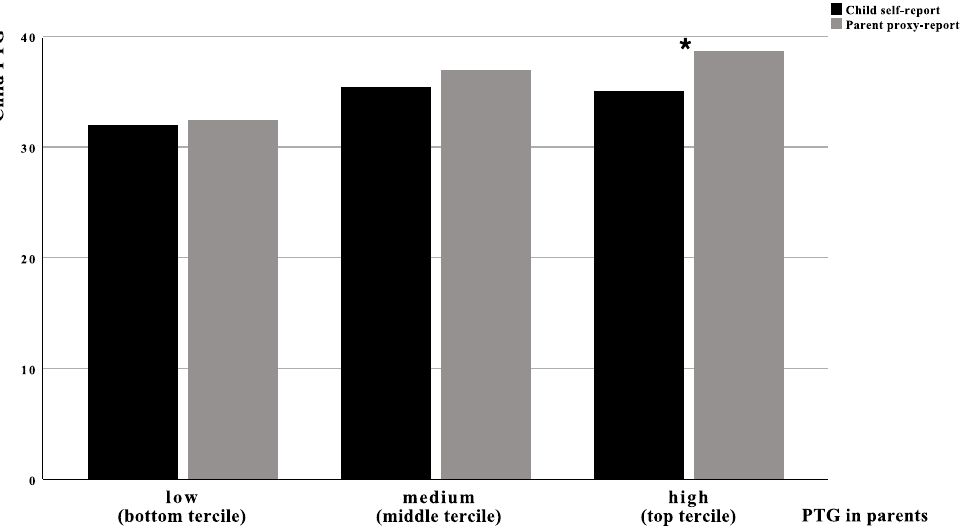
Figure 1. Level of child PTG according to self-reports and the parents’ proxy reports and the level of PTG in parents. * p ≤ 0.05.